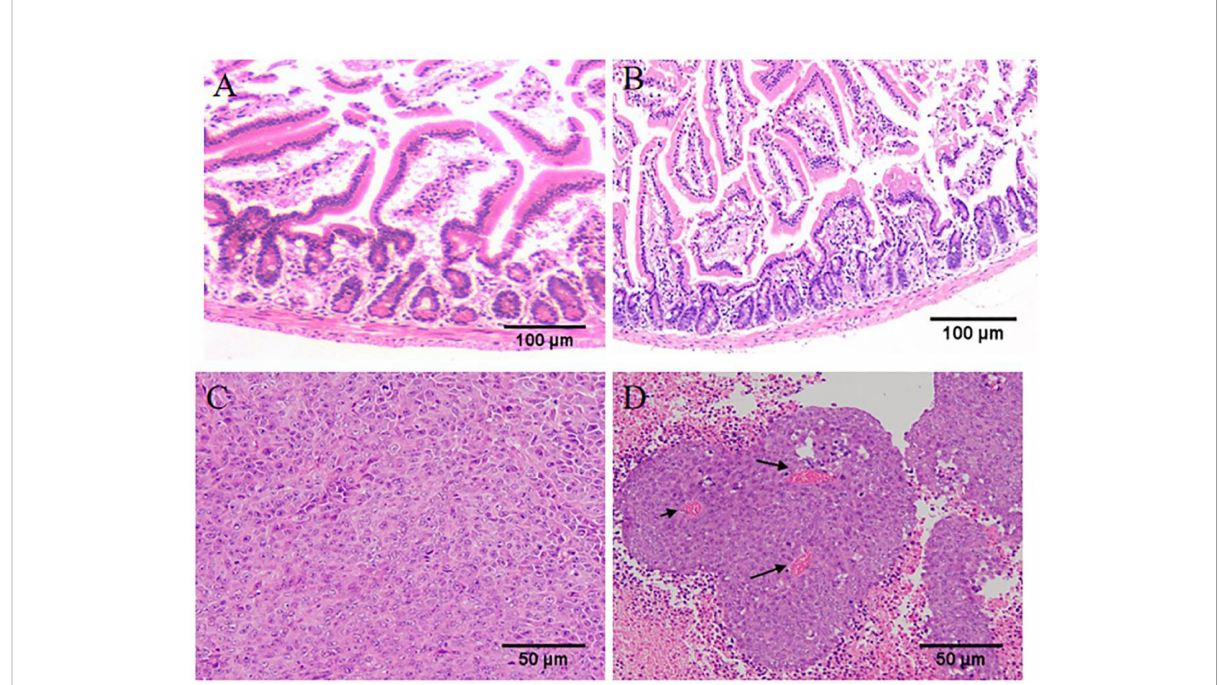
FIGURE 7 Supplementation of exogenous polyamines can meet the requirements of polyamines for tumor growth and avoid the predation of polyamines in the intestinal mucosa. (A) The structure of intestinal mucosa of tumor-bearing mice in HIF1 a (+/+) group under light microscope. (B) Intestinal mucosal structure of tumor-bearing mice in Spd group. (C) . Tumor structure of tumor-bearing mice in HIF1 a (+/+) group under light microscope. (D) Tumor structure of tumor-bearing mice in Spd group. (AB: ×100; CD: